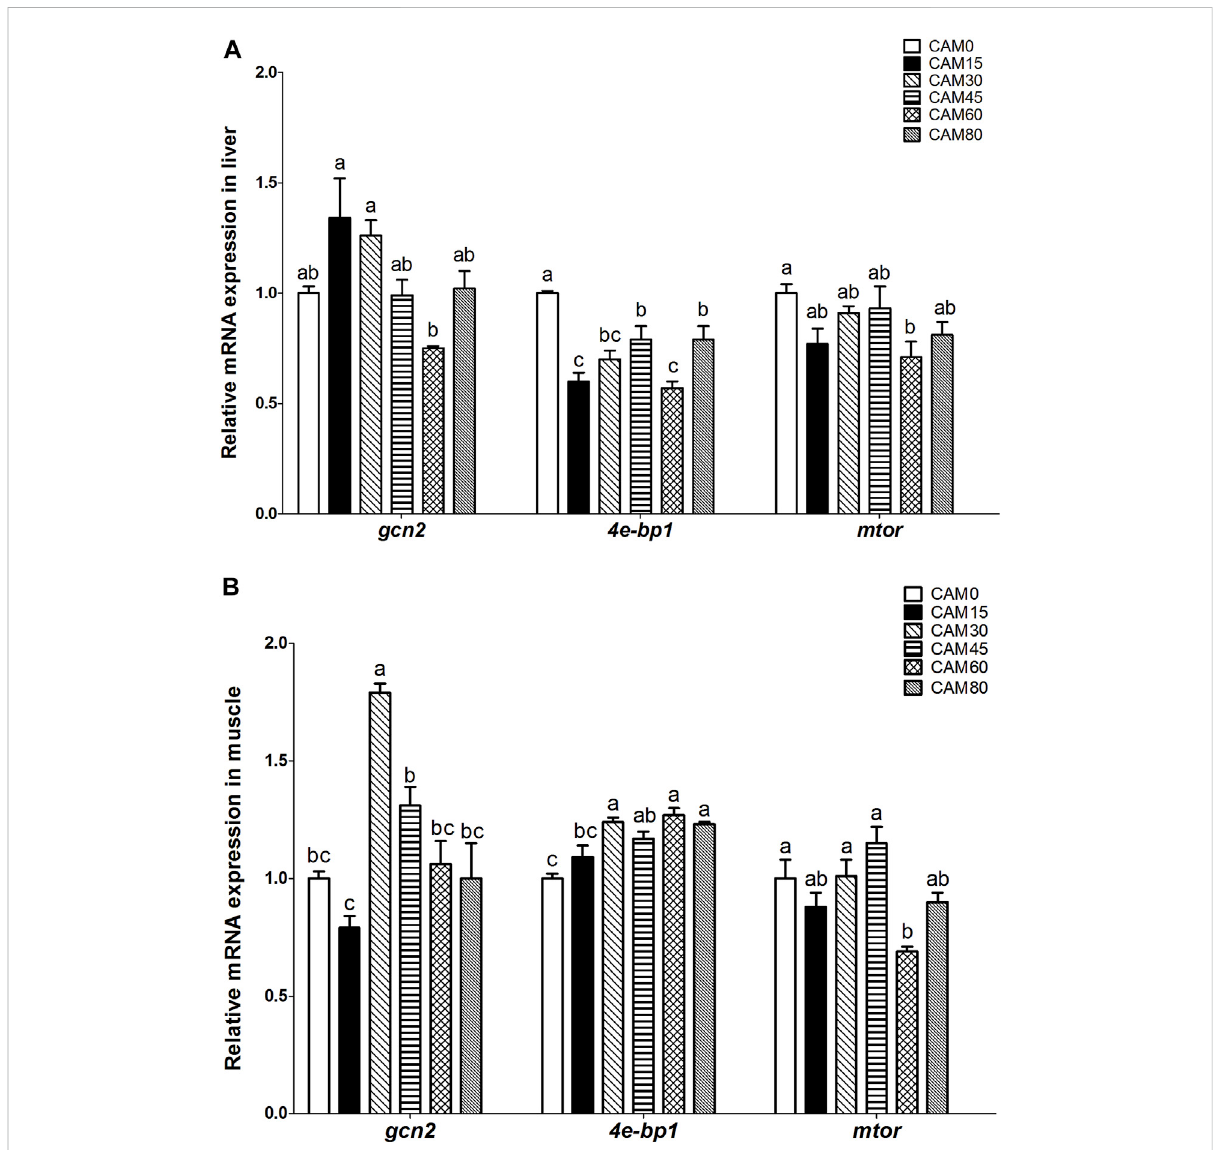
FIGURE 3 Relative mRNA expression related to protein metabolism in liver (A) and muscle (B) of juvenile turbot fed different diets. Data are presented as means ± S.E.M ( n = 3). Columns sharing the same superscript letter or absence of superscripts are not signi fi cantly different determined by Tukey ’ s test ( p > 0.05). Transcriptional levels were normalized by the reference gene of RNA polymerase II subunit D ( rpsd ). gcn2 , general control nonderepressible 2; mtor , mammalian target of rapamycin; 4e-bp1 , eukaryotic initiation factor 4E-binding protein 1. Polynomial analysis in (A) : gcn2 : P value = 0.003, P Linear =0.454, P Quadratic = 0.002; 4e-bp1 : P value = 0.000, P Linear = 0.000, P Quadratic = 0.001; mtor : P value = 0.038, P Linear =0.123,